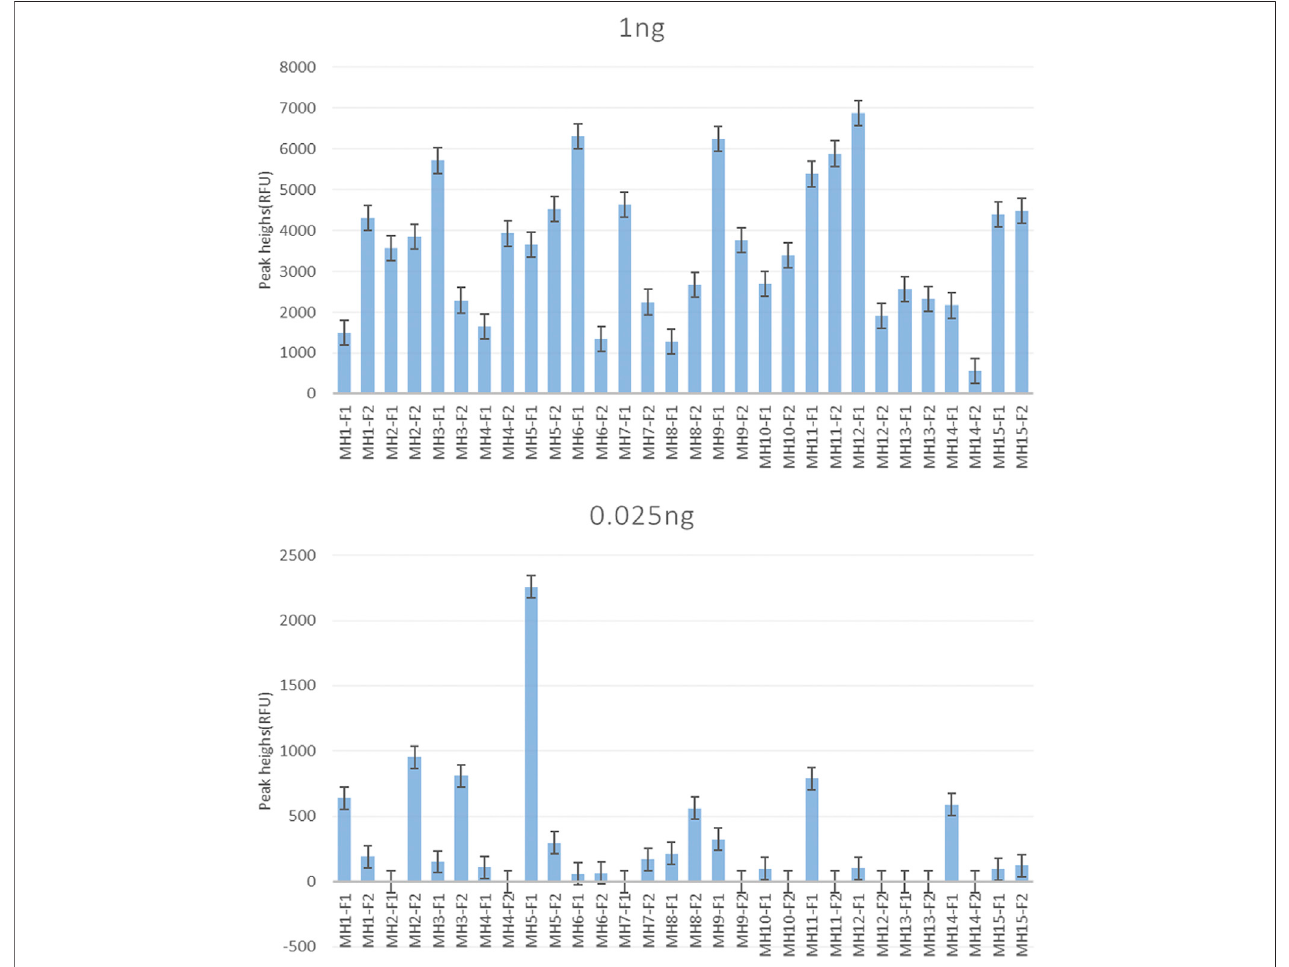
FIGURE 2 | Sensitivity of the single allele-speci fi c primer. MH1~MH15 correspond to 15 SNP-SNPs markers. Also, F1 and F2 represent the two forward allele- speci fi cprimersforeachlocus.Theresultsshowthepeakheightofeachprimerusing1and0.025 ngofthetemplateDNA.ExceptforMH2-F1,MH4-F2,MH7-F1,MH9- F2, MH10-F2, MH11-F2, MH12-F2, MH13-F1/F2, and MH14-F2, which had a detection sensitivity of 0.05 ng, and the other primers showed a positive result of 0.025